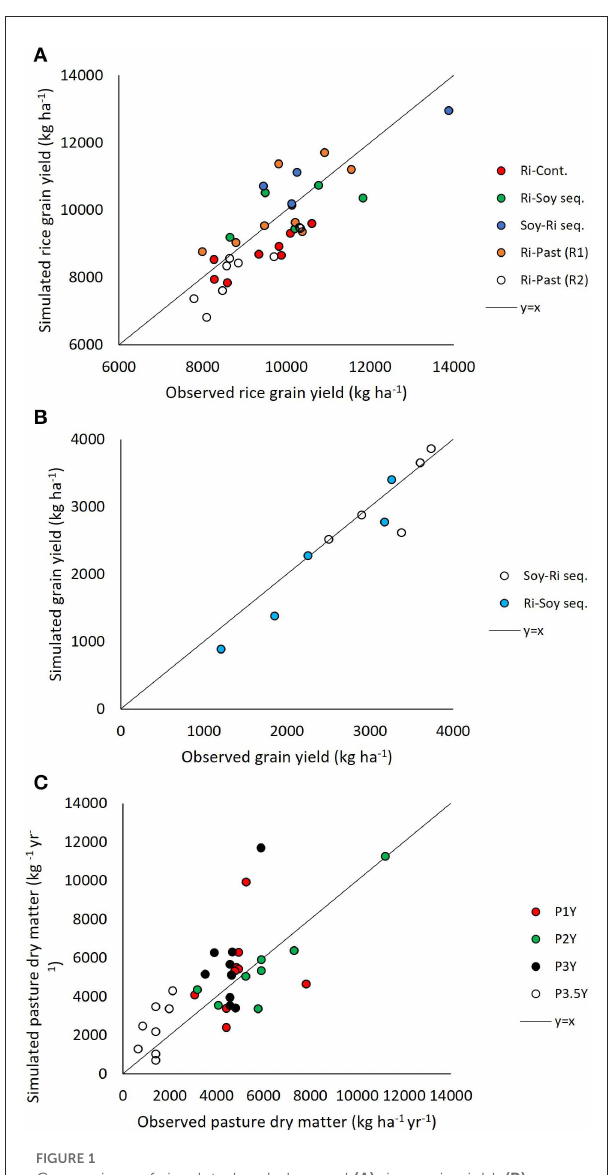
FIGURE1 Comparison of simulated and observed (A) rice grain yield, (B) soybean yield, and (C) pasture dry matter from 2012 to